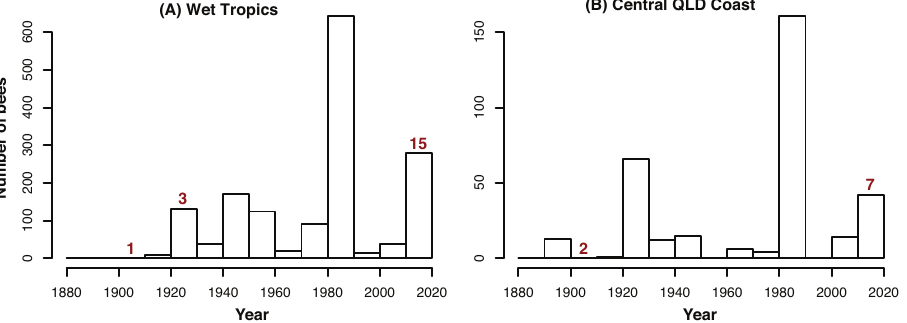
Figure 2. The number of bee specimens recorded on the Atlas of Living Australia for the A Wet Tropics and B Central Mackay Coast bioregions in ten-year intervals. Numbers above bars indicate Pharohylaeus lactiferus specimen collections.